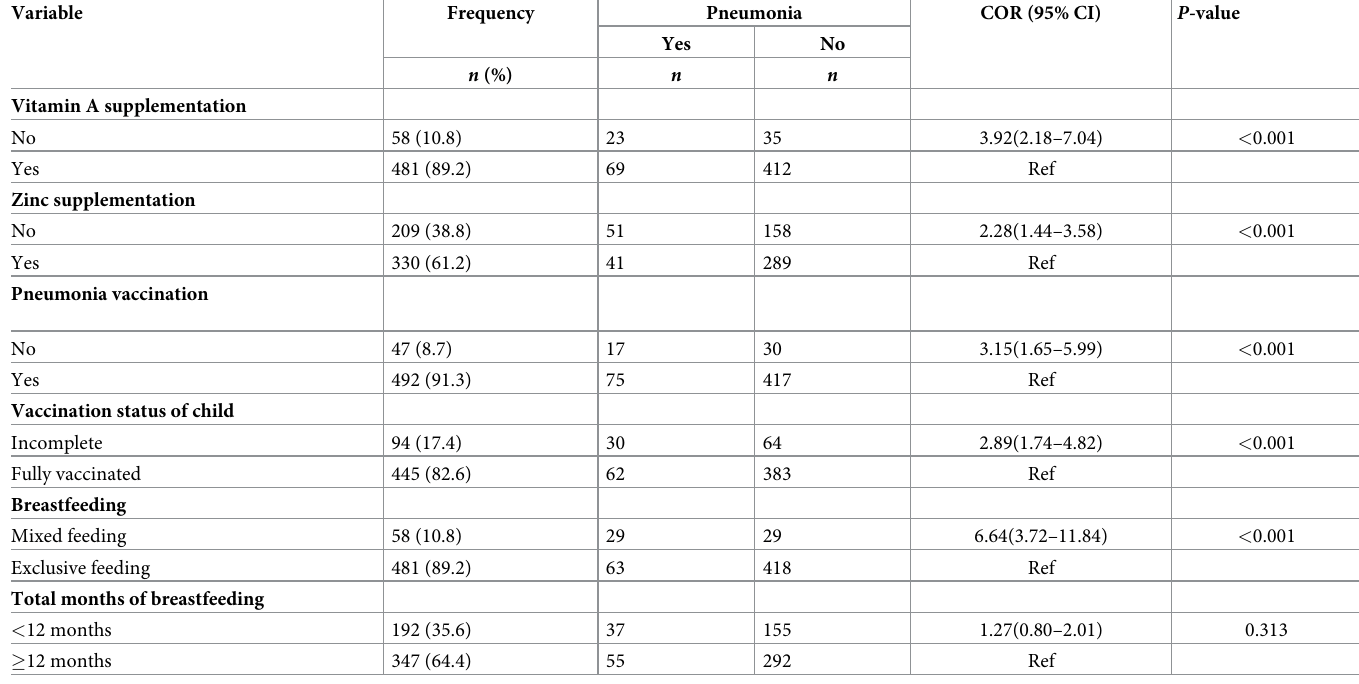
Table 3. Bivariate analysis of the association of nutritional and immunization factors with pneumonia among children under five in peri-urban areas of Dessie City, north-eastern Ethiopia, January—March